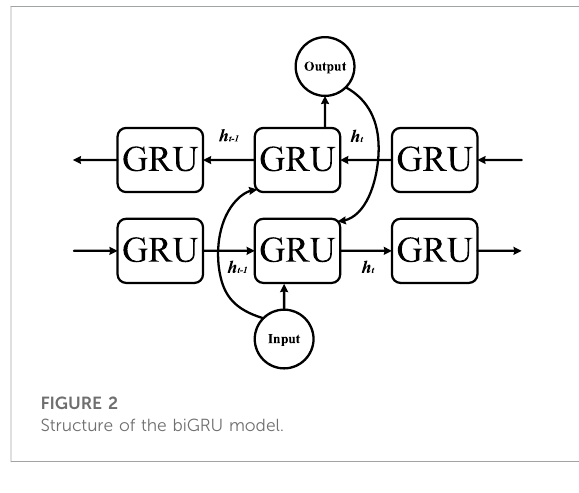
FIGURE 2 Structure of the biGRU